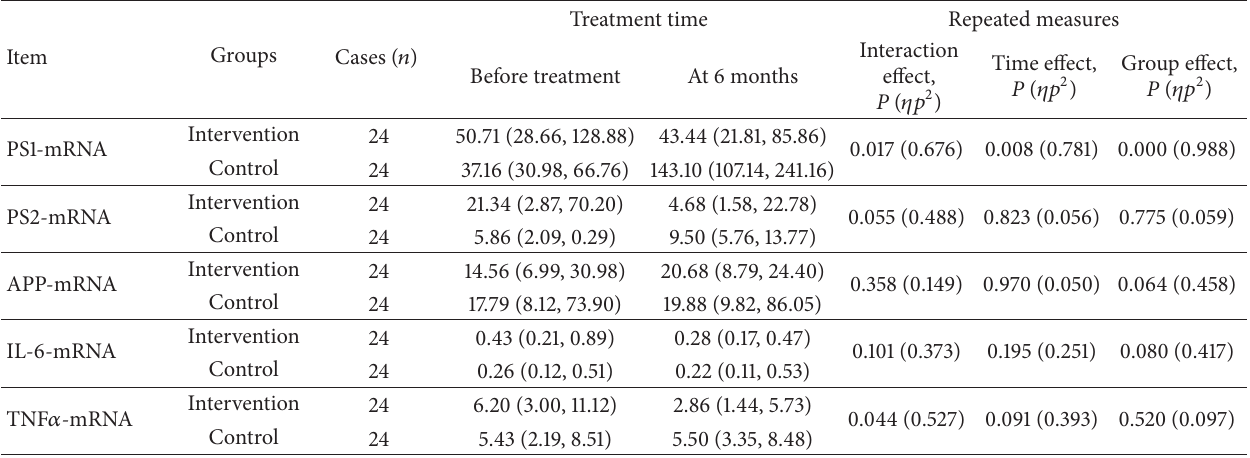
Table 4: ThemRNAlevels of genes related toserumbiomarker parameters at baselineand 6-monthfollow-up infolicacid and control